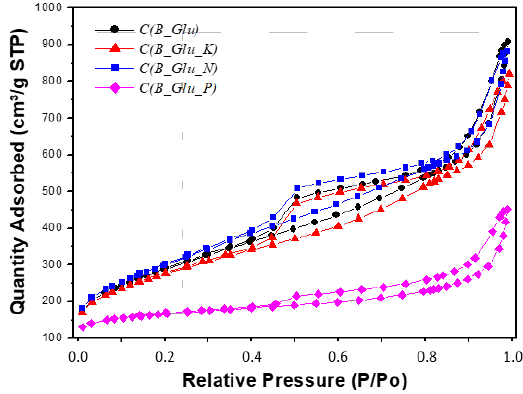
Figure 5. N 2 isotherms of the synthesized carbons.